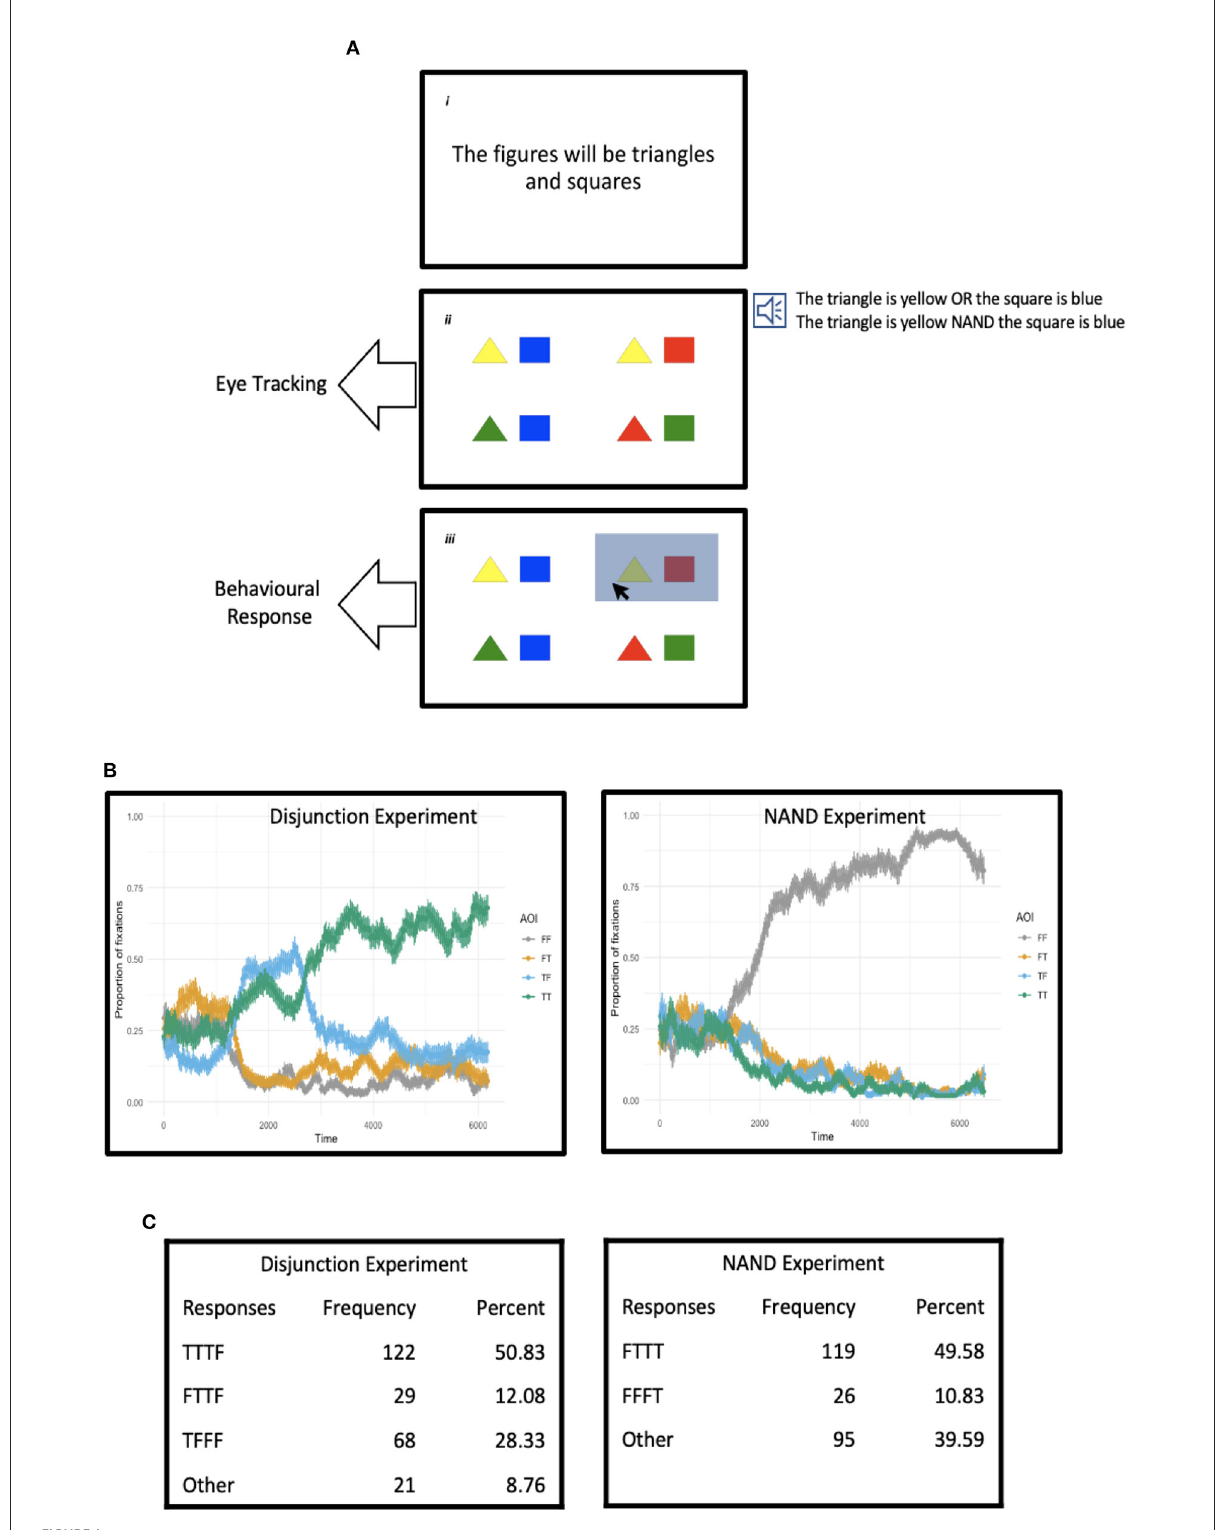
FIGURE1 Interpreting and thinking with existent and non-existent verbal connectives. (A) (i) Panel specifies the figures participants see in a trial. (ii) Each quadrant in the experimental panel presents two figures in diverse combinations of colours. An audio of a sentence describing one or more quadrants is played soon after the figures appear, as shown to the right of the panel. Each quadrant represents a combination of the truth values